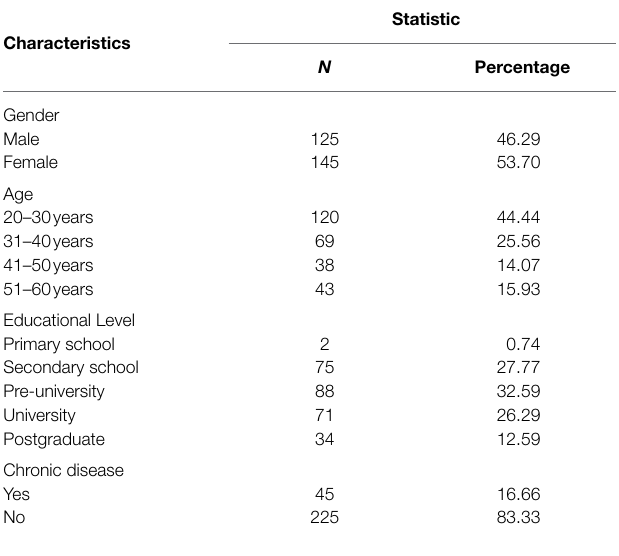
TABLE 2 | Demographic profile of the